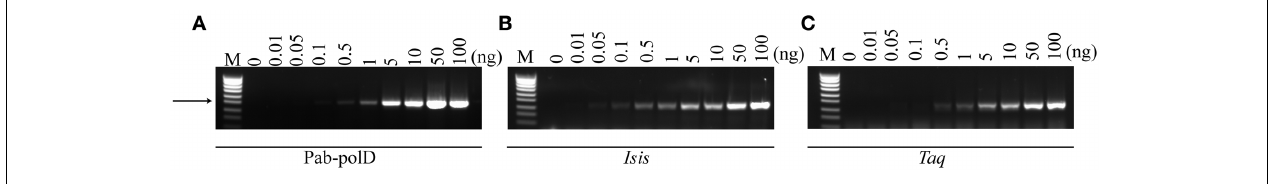
FIGURE 2 | Effect of input genomic DNA on PCR efficiency and specificity. PCR amplification of the 0.5kb target ( Table 1 ) was carried out with 0.1 U of Pab-polD (A) , 1 U of Pab-polB (B) , and 1 U of Taq-polA (C) in their respective reaction buffer ( Table 2 ). PCR program